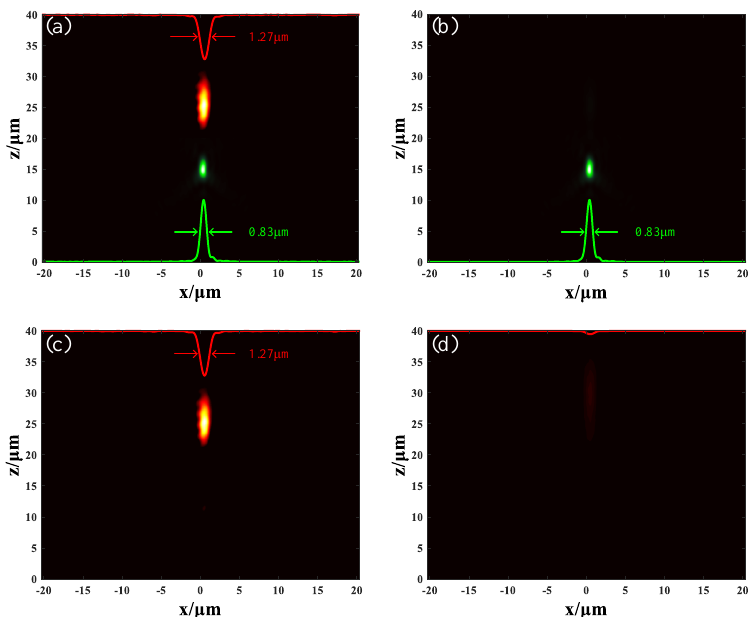
Figure 8. The light field distribution of metalens M 4 . ( a ) The GST in both sections are in amorphous state. ( b ) The GST in section A stays in amorphous state while the GST in section B stays in crystalline state. ( c ) The GST in section A stays in crystalline state while the GST in section B stays in amorphous state. ( d ) The GST in both sections are in crystalline state. Table 1. Comparison of the four metalenses.